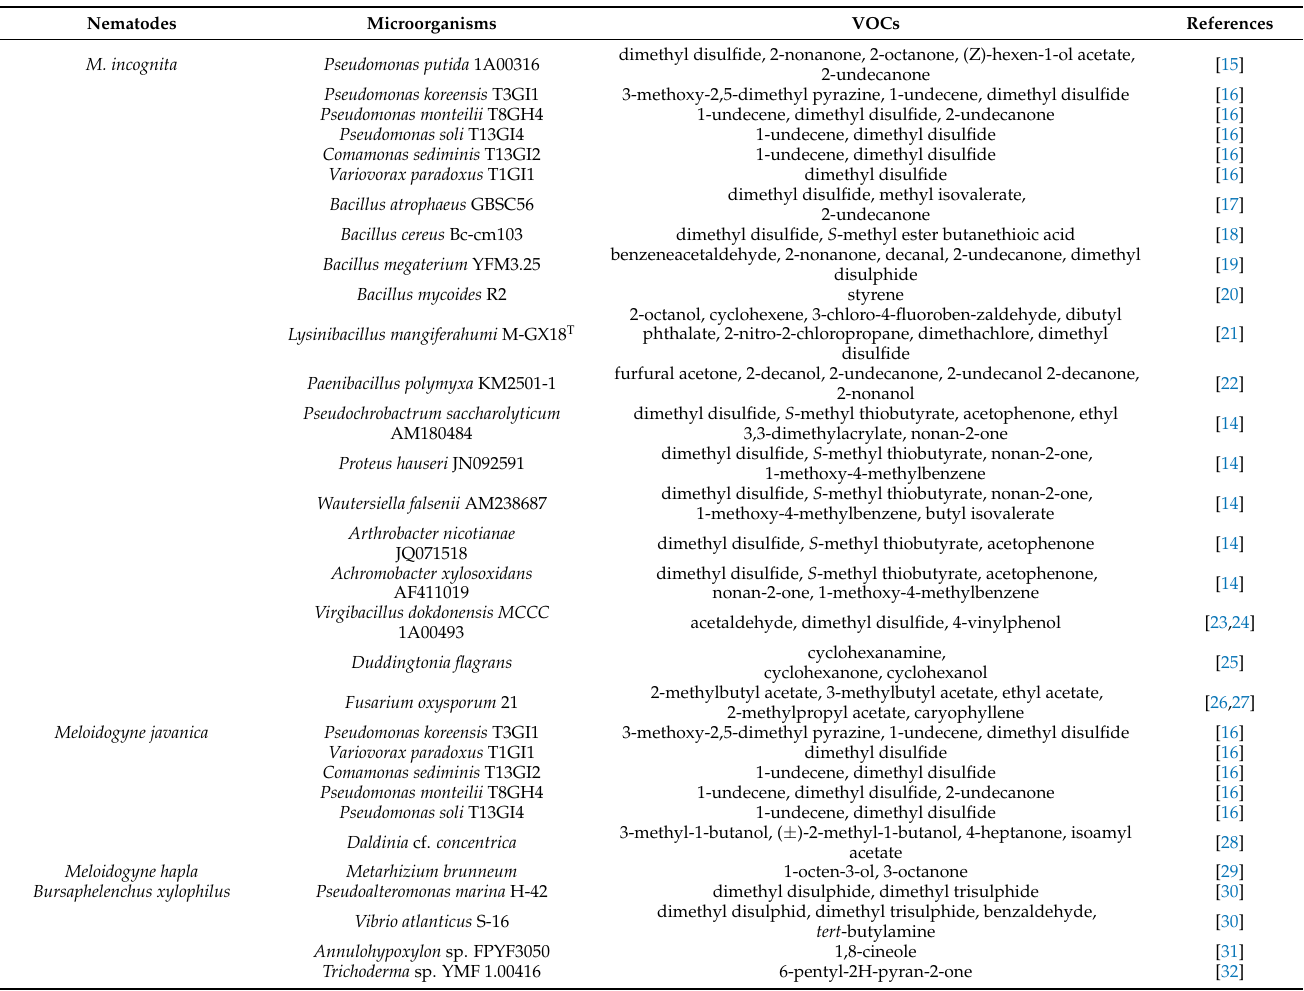
Table 1. Nematicidal activity of VOCs produced by microorganisms against Meloidogyne spp. and B. xylophilus